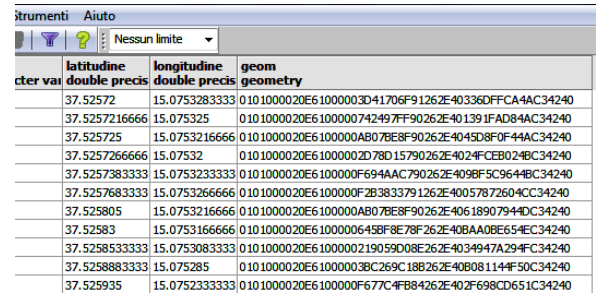
Figure 4. Structure of the spatial